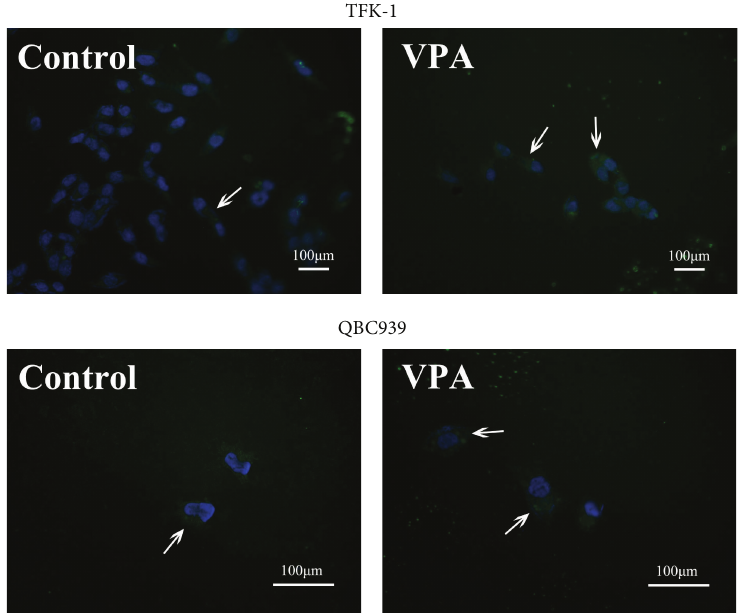
Figure 7: Sodium Valproate induces autophagy in TFK-1 cells and QBC939 cells. TFK-1 cells and QBC939 cells were transfected with green fluorescenceprotein(GFP)andtaggedwithMAP-LC3(GFP-LC3)plasmidandtreatedwithsodiumvalproateat2 mMand8 mM,respectively. The formation of punctate GFP-LC3 spots is indicative of autophagy (short